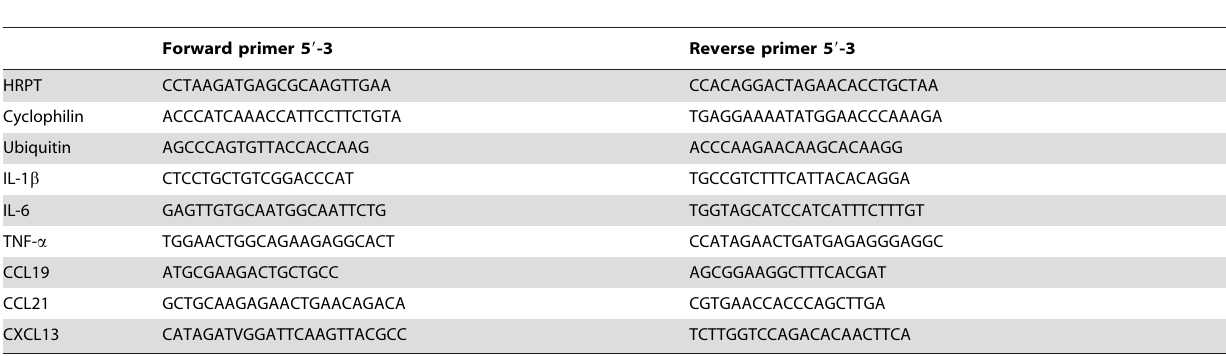
Table 1. Primer sequences for analysis of mouse intestine and spleen